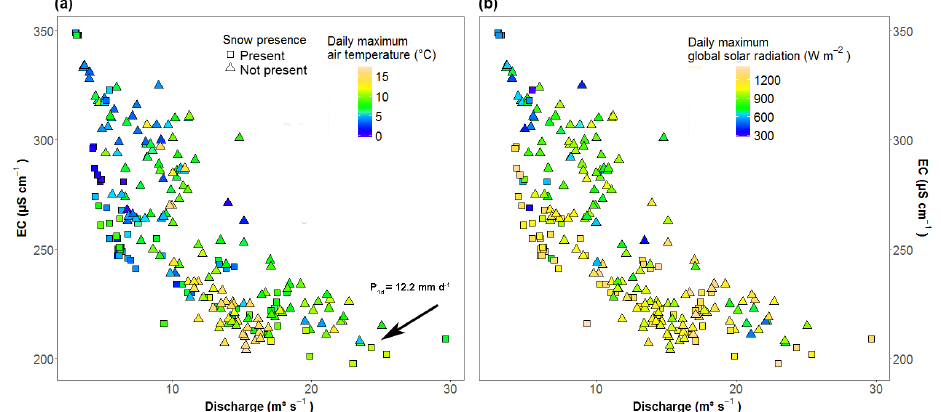
Figure 10. Monthly relationships between discharge and electrical conductivity (EC) at the outlet Stilfserbrücke with respect to (a) daily maximum air temperature (1d) and (b) daily maximum global solar radiation (1d) compared to the snow presence measured at the AWS Madritsch in 2014 and 2015. Different symbols indicate the snow presence. Different symbols indicate the snow presence. Different symbols indicate the snow presence. The arrow indicates a storm